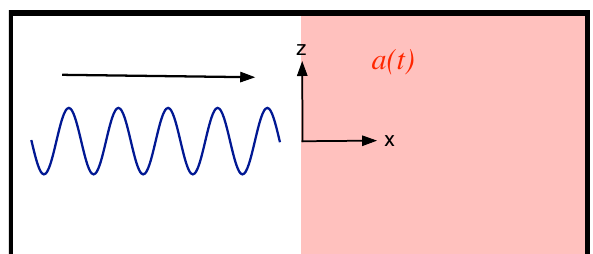
Fig. 1 Incident plane electromagnetic wave with wave vector (cid:6) k = ω ˆ x and linearly polarized in ˆ z . The pink region corresponds to a homoge- neous axion dark matter background